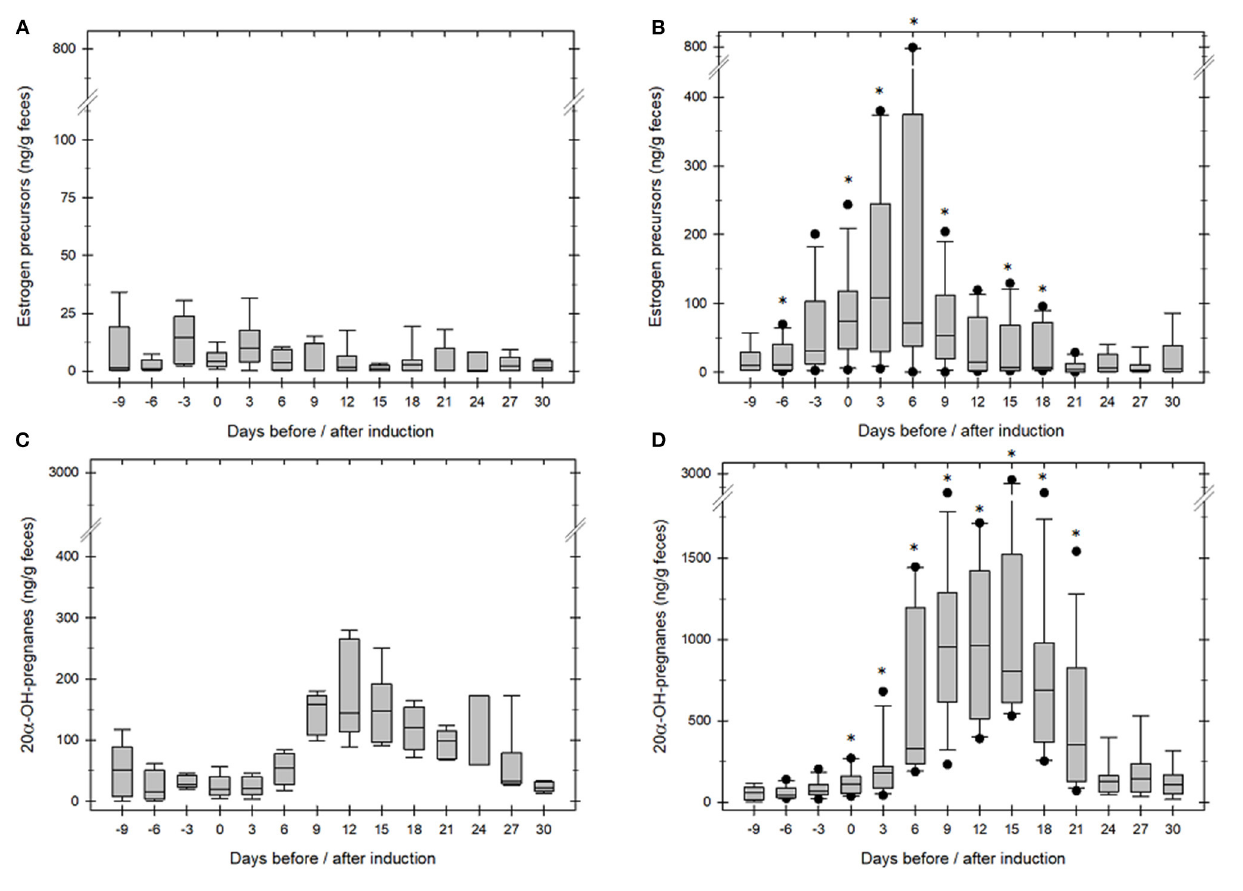
FIGURE 2 | Fecal estrogen (A,B) and pregnane (C,D) concentration in anestrous GOH rhinoceros. Day 0 marks the day of hCG/GnRH injection. (A,C) : When ovulation was not induced median estrogen and pregnane remained low before and after treatment ( n = 4). (B,D) : When ovulation was induced median estrogen increased significantly before ( p ≤ 0.02) and gestagen significantly after ovulation ( n = 7, p ≤ 0.01) compared to concentrations during an-ovulatory estrous (A,C) . *asterisk mark days median estrogen or pregnane concentrations were significantly different between groups ( p ≤